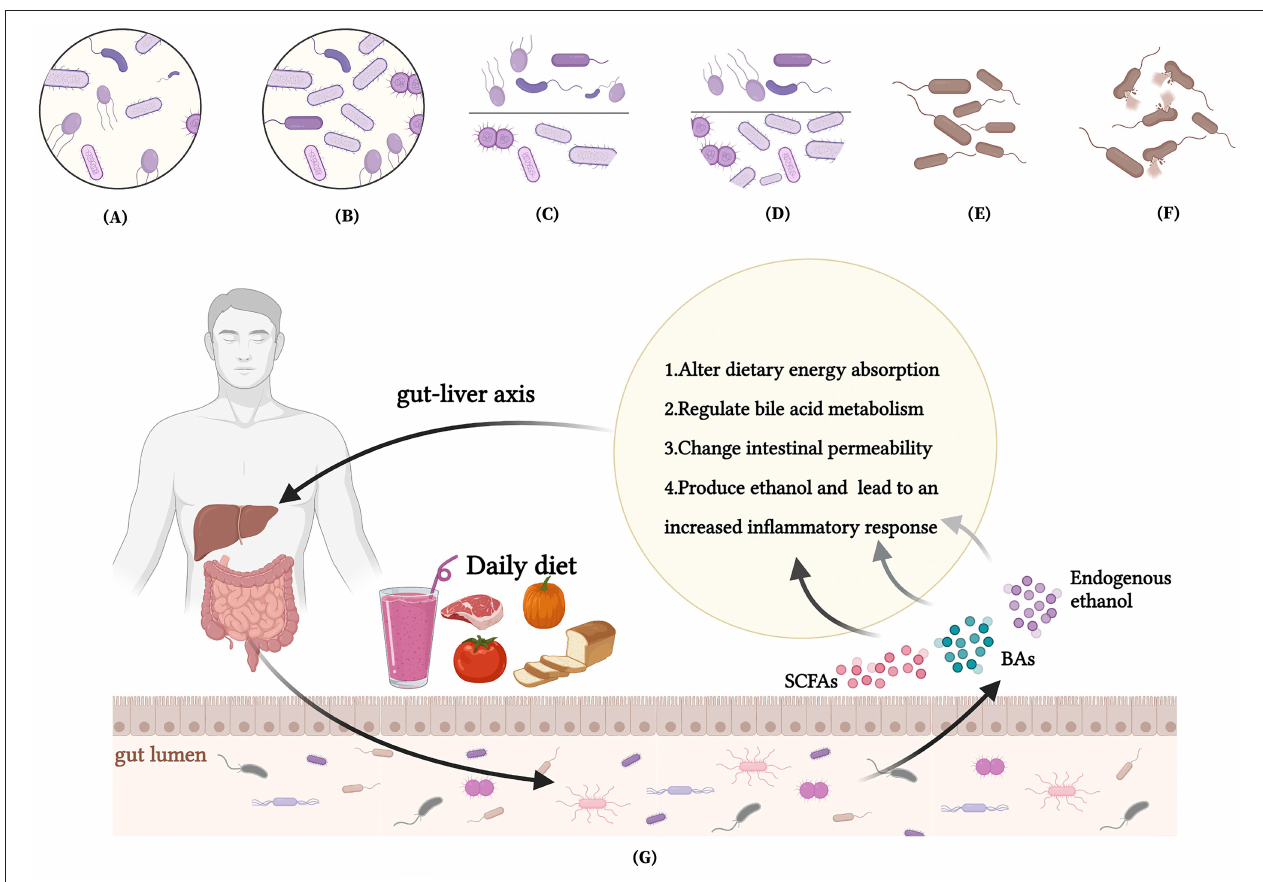
FIGURE 3 | Interactions between nutrients, intestinal microbiota and MAFLD. (A) A low intestinal microbiota abundance in MAFLD patients; (B) Dietary interventions enrich the intestinal microbiota abundance of MAFLD patients; (C) An increased Firmicutes/Bacteroidetes(F/B) ratio in MAFLD patients; (D) Dietary interventions reduce F/B ratio of patients with MAFLD; (E) A reduced abundance of beneficial bacteria in MAFLD patients; (F) Dietary interventions promote abundance of beneficial gut microbes to reestablish the balance of gut microbes; (G) How nutrients affect MAFLD through intestinal microenvironment and